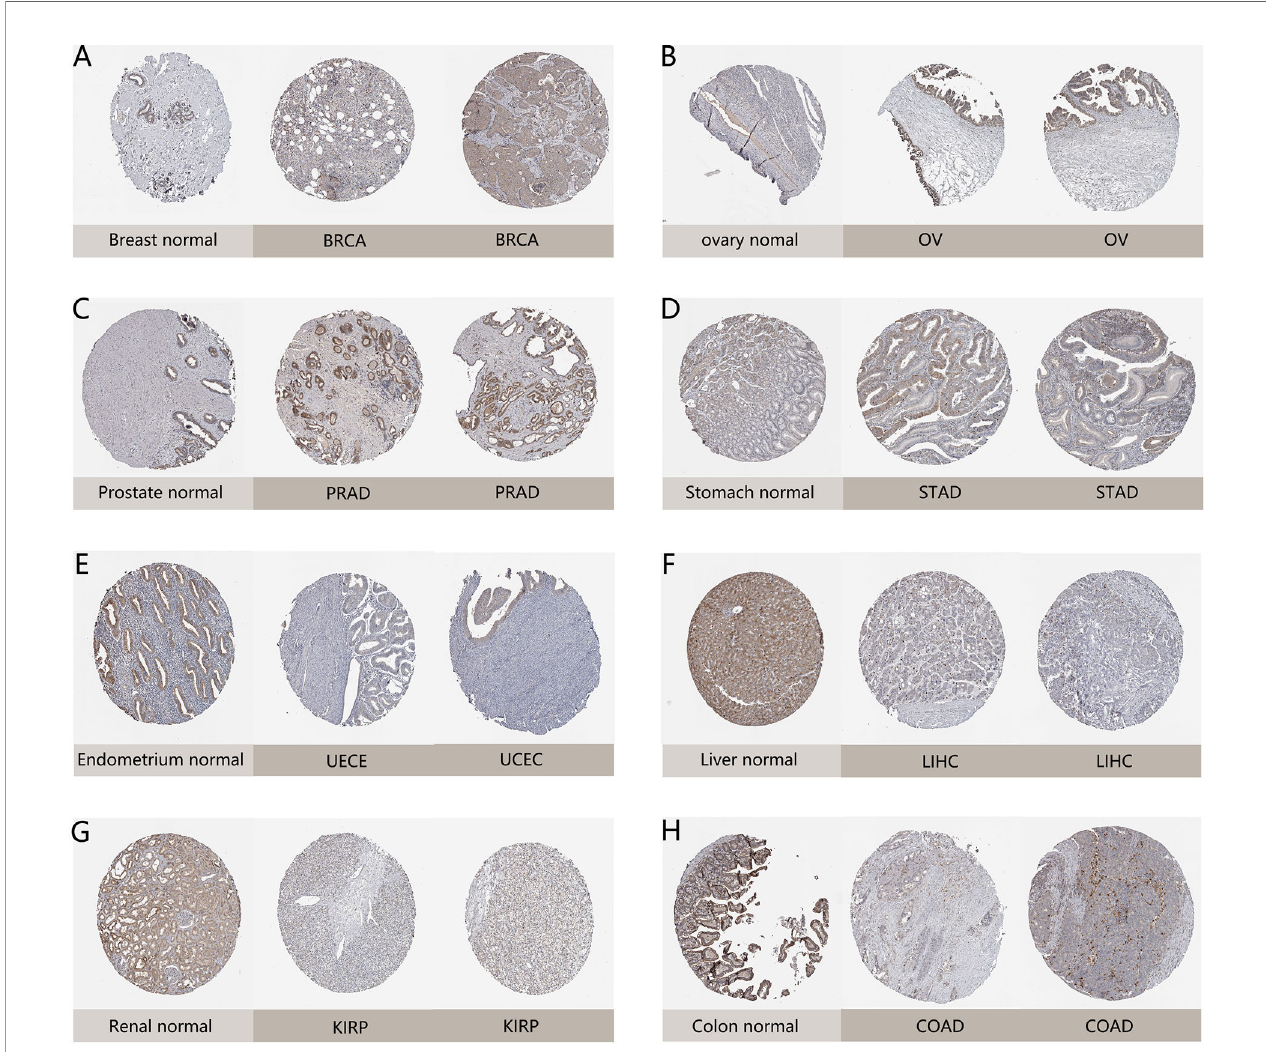
FIGURE 2 | Representative immunohistochemical staining (IHC) in various normal (left) and tumor (right) tissues. The protein expression of NAAA in (A) lobular breast carcinoma, BRCA; (B) ovarian serous cystadenocarcinoma, OV; (C) prostate adenocarcinoma, PRAD; (D) stomach adenocarcinoma, STAD; (E) endometrial adenocarcinoma, UCEC; (F) liver hepatocellular carcinoma, LIHC; (G) kidney renal papillary cell carcinoma, KIRP; (H) colon adenocarcinoma,